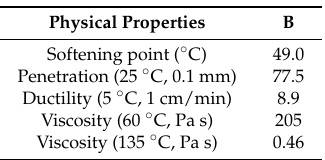
Table 2. Physical properties of